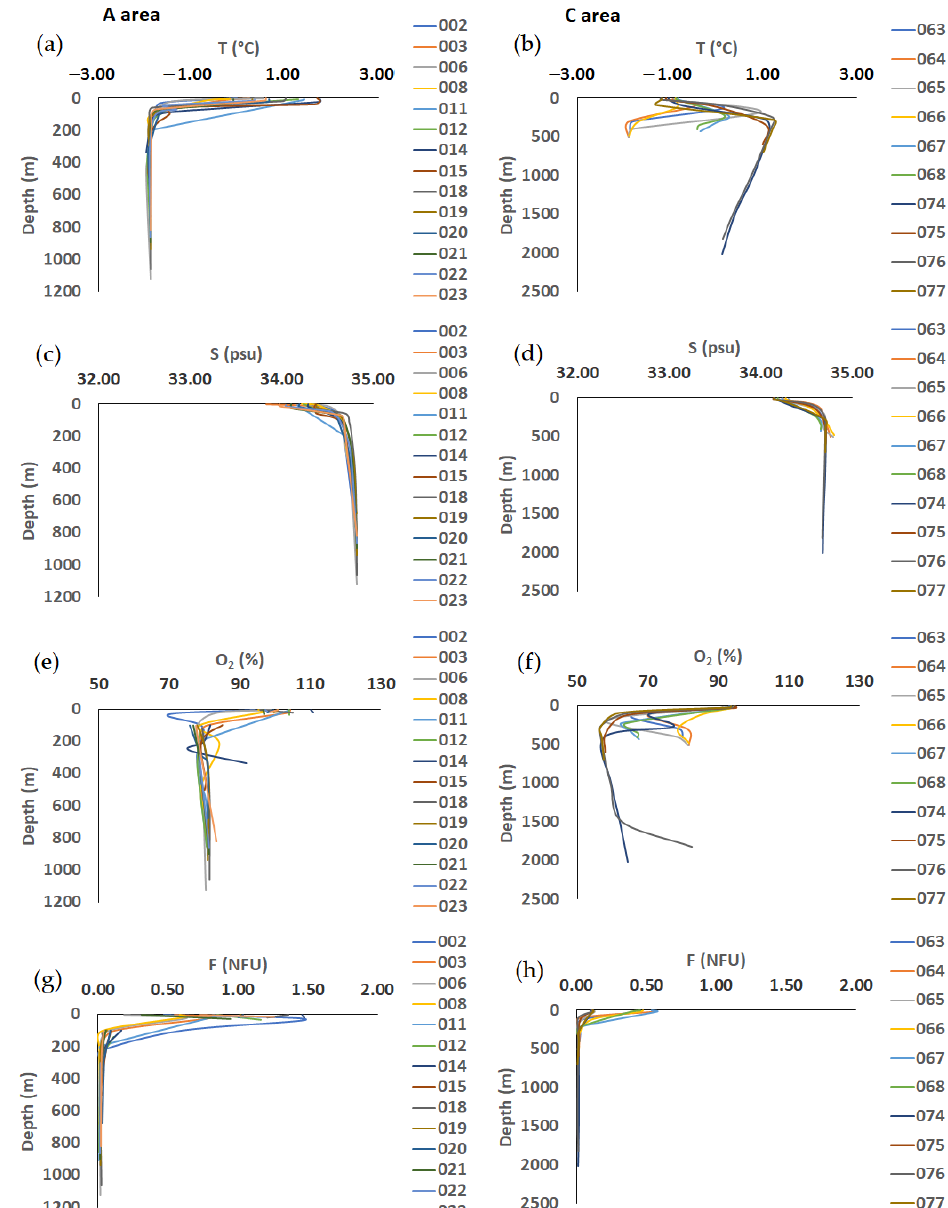
Figure 3. CTD profiles for the two areas: Area A (Drygalski glacier and Terra Nova Bay polynya) and Area C (Cape Adare shelf break area). ( a , b ) temperature; ( c , d ) salinity; ( e , f ) dissolved oxygen; ( g , h )